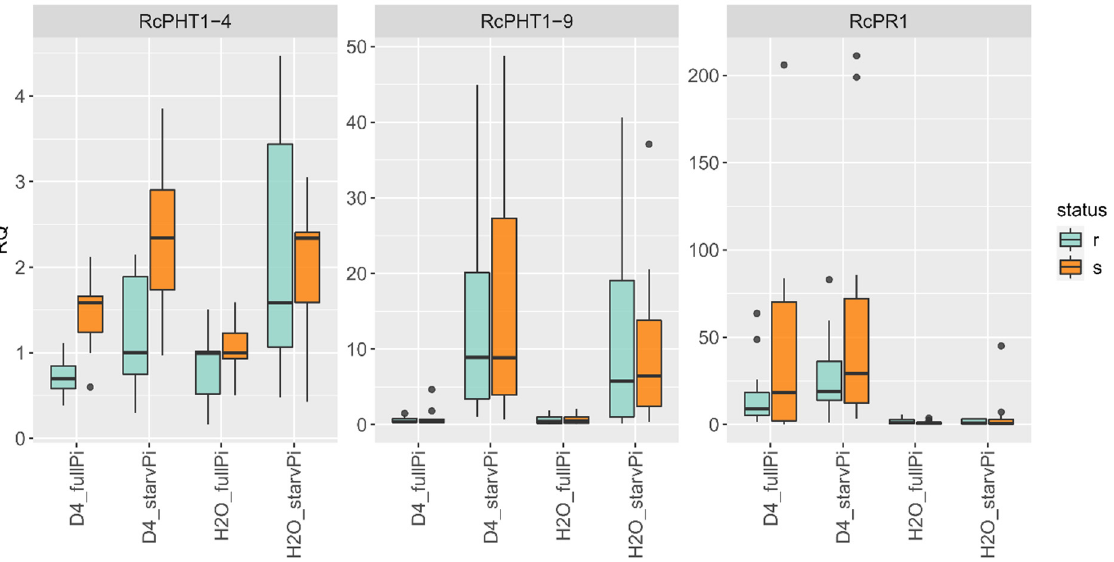
Figure 6. Expression changes of groups of resistant (r_123, r_131, r_189) or susceptible (s_104, s_126, s_183) genotypes. RT-qPCR analysis of a combined stress experiment in leaves of six 97/7 rose genotypes at 3 dpi. Two Pi treatments (“fullPi” and “starvPi”) and additional inoculation with D. rosae (“D4”). Expression changes of each genotype relative to “H 2 O_fullPi”. Data are represented as boxplots of RQ values (relative quantification = 2 −ΔΔ Ct ), n = 12. Table S5 provides further data.